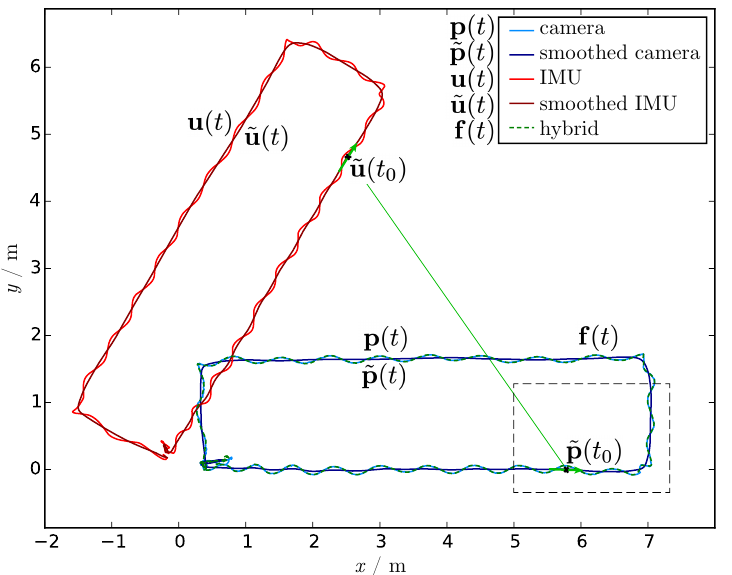
Figure 2. Trajectories of the top of Figure 1 from a person’s head walking along a rectangle, where the red IMU trajectory u is rotated by 60° for demonstration purposes only. The smoothed trajectories ˜ p and ˜ u are displayed darkened. The dashed green path f shows the resulting fused trajectory of the hybrid tracking system (HTS). The dashed region is enlarged in Figure 3 to show the rotation angle resulting from the main movement directions of the smoothed camera and IMU